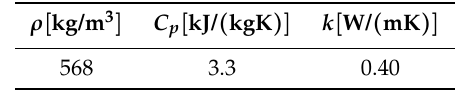
Figure 2. Experimental measurement of the thermal coefficient k for a representative pasty. ( a ) shows a schematic representation of the experimental setup with PHFS-01 Heat Flux sensors inserted at the centre and surface of the pasty. Data in ( b ) represents the temperature profiles at the core and the surface of the Cornish pasty, the distance between the core and surface being 2.5 cm. Data in ( c ) shows the experimental and empirical values of the heat conductivity coefficient of the Cornish pasty. Error bars in the experimental measurements have been estimated from measurement errors for the different input parameters. Table 2. Thermal properties of Cornish Pasty ( T > 0 ◦